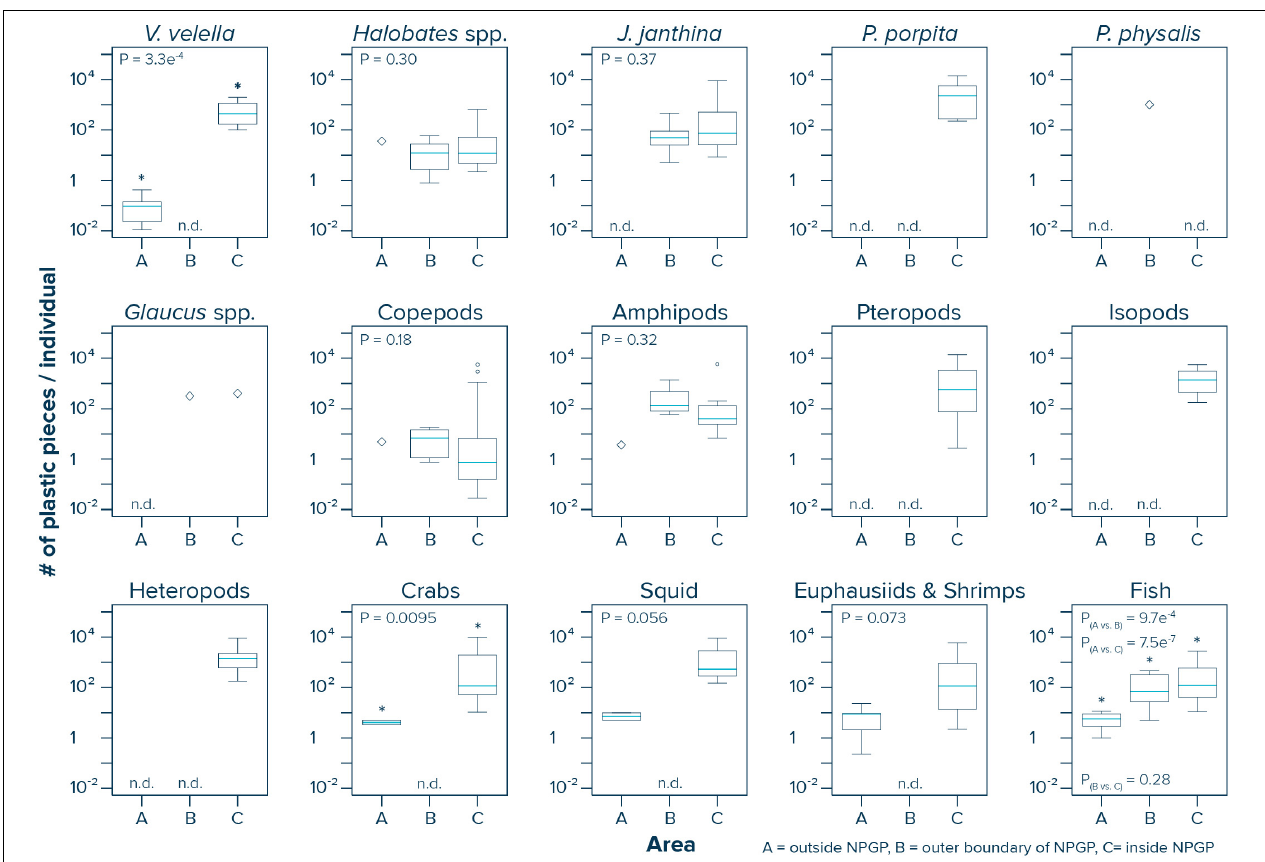
FIGURE 4 | Numbers of plastic pieces (0.05–5 cm in size) present per individual species observed in Manta trawls deployed outside the NPGP (Area A), in the outer boundary of the NPGP (Area B) and inside the NPGP (Area C). Horizontal lines represent median values. Box plots extend from the 25th to the 75th percentiles, while whiskers extend from the minimum to the maximum observed values. Large diamonds indicate that the species was only present in one Manta trawl. Dots indicate outliers. n.d., not detected in any of the Manta trawls. Asterisk indicates a statistically significant ( P < 0.05; Wilcoxon–Mann–Whitney test) difference between the sampling areas. Note that these ratios are based on uncorrected plastic